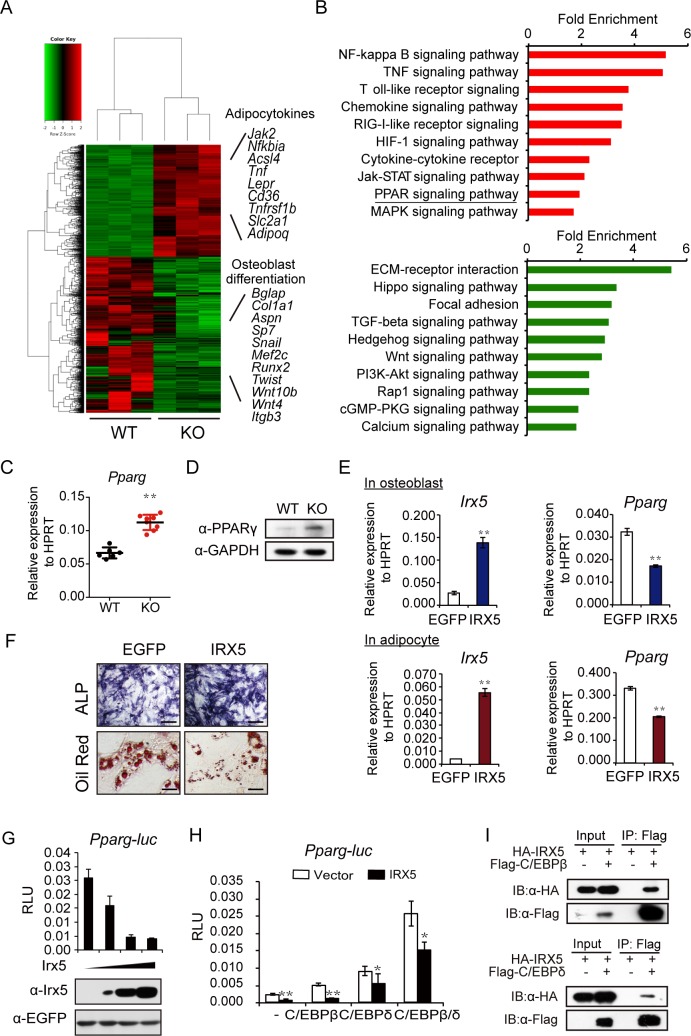
Irx5 promotes osteogenesis and inhibits adipogenesis by suppressing PPARγ activation.(A) Heat map of RNA-seq data between wild-type and Irx5 knockout BMSCs cultured in osteoblast differentiation medium for 4 days, n = 3 for each group. (B) Up-regulated (red) and down-regulated (green) pathways associated with significantly regulated genes (P < 0.05) in Irx5 knockout versus wild-type control. (C) qPCR results of Pparg expression in the tibiae and femurs from wild-type and Irx5 knockout mice. n = 6 for WT and n = 8 for KO mice. (D) Western blotting analysis of PPARγ in the tibiae and femurs from wild-type and Irx5 knockout bone tissue. (E) Gene expression levels of Irx5 and Pparg in the cultured osteoblast and adipocyte from wild-type BMSCs infected with lentivirus expressing vector control or IRX5. (F) ALP staining of the cultured osteoblast and Oil Red staining of the cultured adipocyte from wild-type BMSCs infected with lentivirus expressing vector control or IRX5. Scale bars, 50 μm (top) and 10 μm (bottom). (G) Irx5 inhibits luciferase activity as judged by Pparg-luc reporter activity in C3H10T1/2 cells. (H) Irx5 represses the transactivation ability of CEBPβ and CEBPδ in inducing Pparg-luc activity in C3H10T1/2 cells. n = 3. (I) In vitro coimmunoprecipitation of HA-IRX5 with Flag-CEBPβ or Flag-CEBPδ following transfection into 293FT cells. **P < 0.01; *P < 0.05 versus control. Data associated with this figure can be found in S1 Data. ALP, alkaline phosphatase; BMSC, bone marrow mesenchymal stem cell; CEBPβ, CCAAT/enhancer binding protein beta; CEBPδ, CCAAT/enhancer binding protein delta; cGMP-PKG, cGMP-dependent protein kinase; C3H10T1/2, murine mesenchymal stem cell line; ECM, extracellular matrix; EGFP, enhanced green fluorescent protein; GAPDH, glyceraldehyde-3-phosphate dehydrogenase; HA, hemagglutinin; HIF-1, hypoxia-inducible factor 1; HPRT, hypoxanthine guanine phosphoribosyl transferase; IB, immunoblotting; IP, Immunoprecipitation; IRX5, iroquois homeobox 5; Jak-STAT, Janus kinase/signal transducers and activators of transcription; KO, knockout; MAPK, Mitogen-activated protein kinases; NF, nuclear factor; PI3K-AKT, phosphatidylinositol 3-kinase- Protein Kinase B; PPARγ, peroxisome proliferator activated receptor γ; Pparg-luc, Pparg promoter-luciferase; qPCR, quantitative polymerase chain reaction; Rap1, Ras-proximate-1; RIG-I, retinoic acid-inducible gene I; RLU, relative light unit; RNA-seq, RNA sequencing; TGF, transforming growth factor; TNF, tumor necrosis factor; Wnt, Wingless/Integrated; WT, wild type; 293FT, human embryonic kidney cell line.